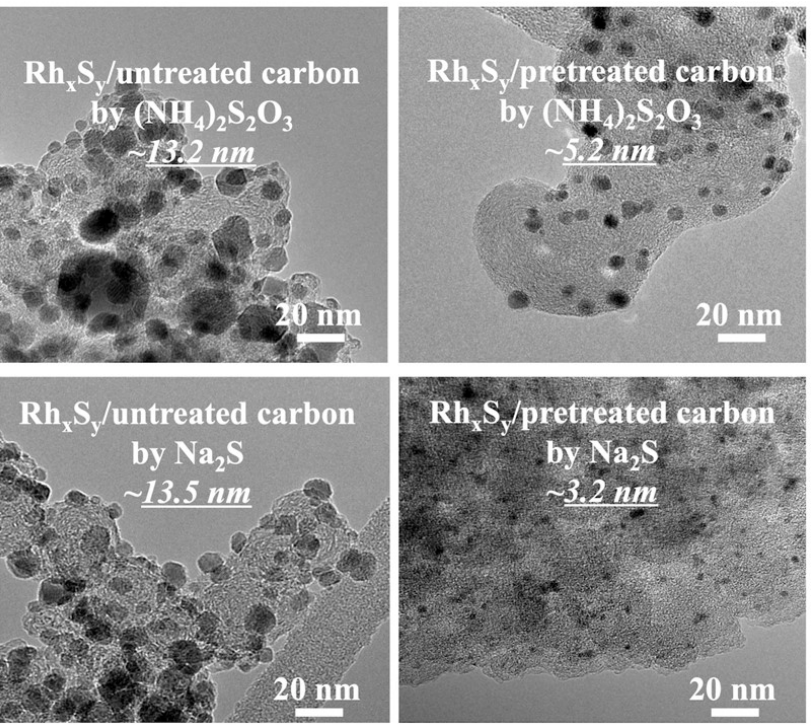
Figure 3. TEM micrographs of the Rh x S y catalysts synthesized on different carbon support materials and with different sulfur sources.